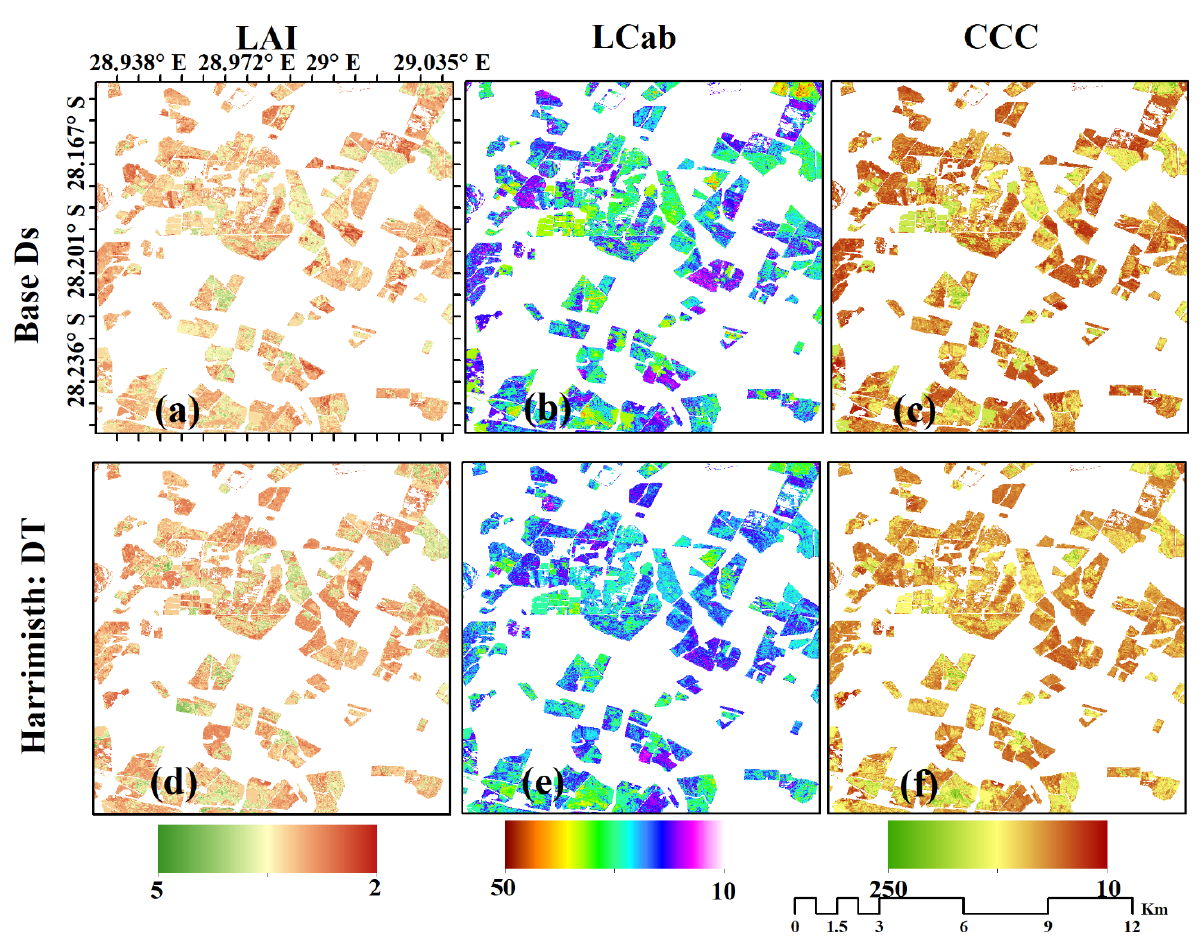
Figure 7. Spatial distribution maps of LAI (i.e., ( a , d )), LC ab (i.e., ( b , e )), and CCC (i.e., ( c , f )) retrieved using XGBoost and Sentinel-2. ( a – c ) were retrieved with Harrismith Source (i.e., Base D S ) models, while ( d – f ) were retrieved with transferred models to Harrismith D T (i.e., Bothaville ( D S ) → Harrismith ( D T )) that achieved superior transferability, i.e., Base D S + 25% for LAI ( d ) and Base D S + 75% for LC ab ( e ) and CCC ( f ).